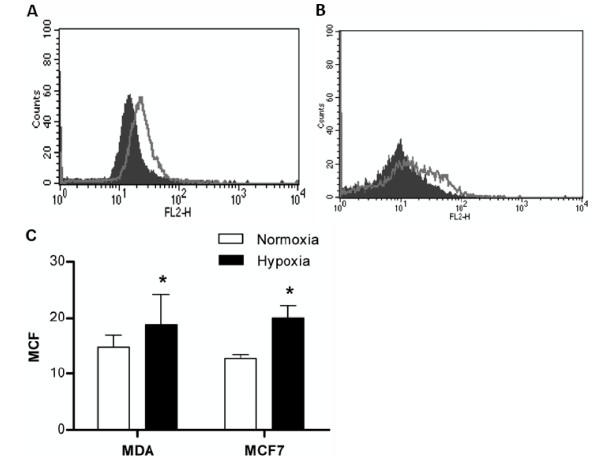
Cell surface expression of CXCR4 in normoxia and hypoxia treated MDA-MB-231 (A) and MCF7 (B) cells. Human breast cancer cell lines, MDA-MB-231 and MCF7 cells were exposed to either normoxia or hypoxia (2% O2 with 5% CO2) for 48 hrs. Cell surface expression of CXCR4 on breast cancer cells was assessed by FACScan analysis, and expressed as mean channel fluorescence (MCF). (A-B) Results shown represent one experiment from a total of three independent experiments. The grey filled indicates CXCR4 expression on normoxia-treated cells, whereas the grey line indicates CXCR4 expression on hypoxia-treated cells. (C) Data are expressed as the mean ± SD of three separate experiments. *p < 0.05 versus normoxia-treated cells.